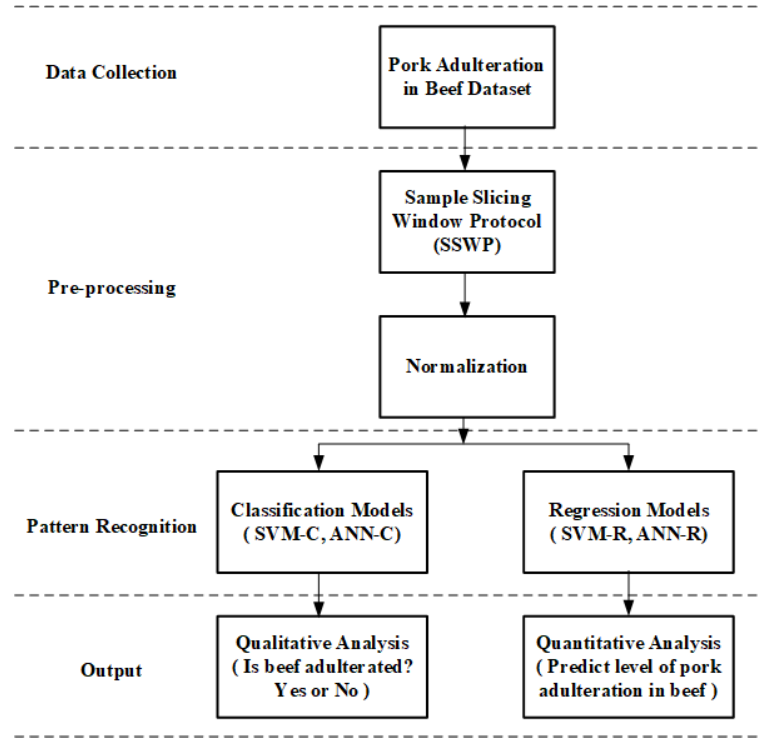
Figure 1. Block diagram of the proposed SE-Nose methodology.